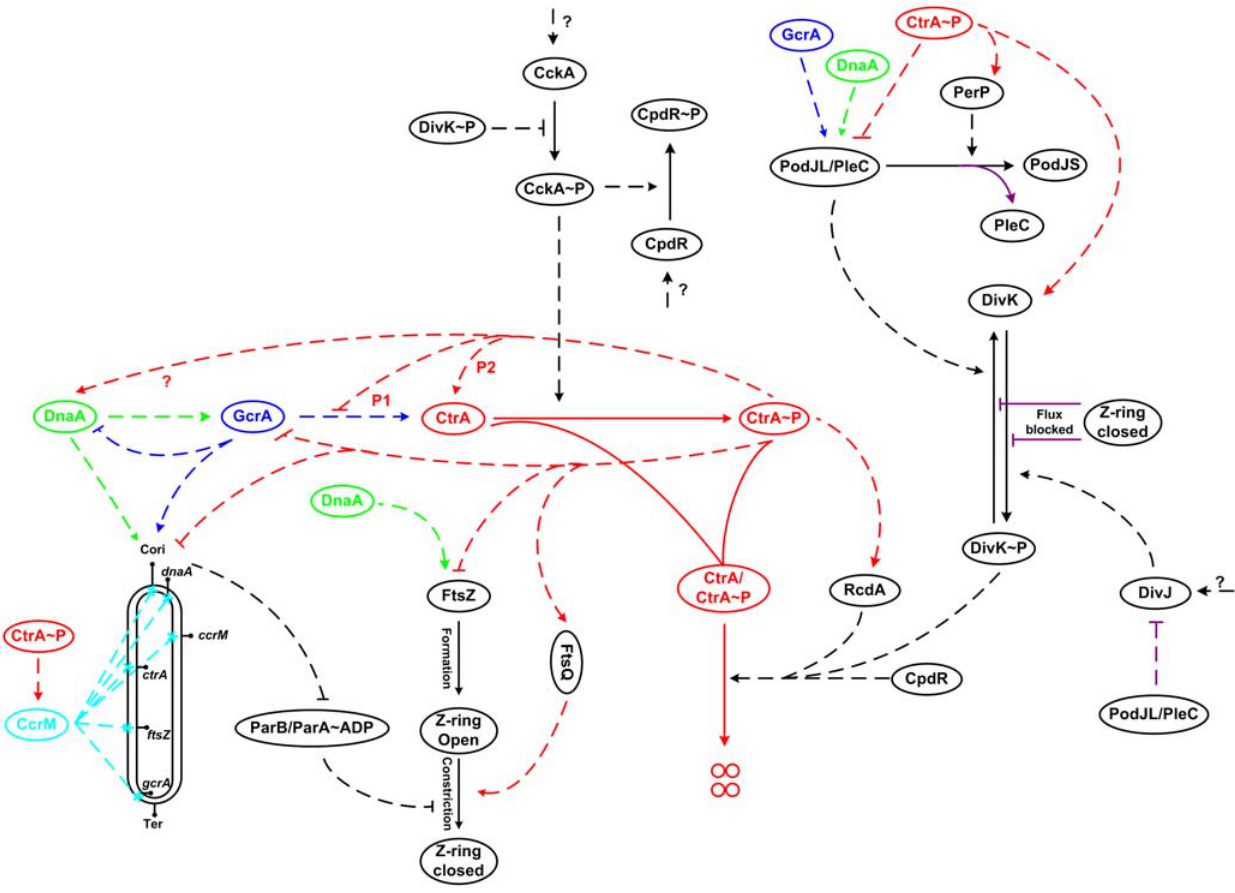
Figure 2. Wiring diagram of the model. All proteins (ovals) are assumed to be produced and degraded at specific rates. Only degradation of CtrA and CtrA , P is depicted explicitly (4 small circles indicate products of degradation), in order to show how these steps are regulated. Solid lines correspond to the mass flow while dashed lines denote regulatory effects. P1 and P2 denote the two promoters controlling CtrA production. Purple lines signify the role of localization/delocalization effects in corresponding regulations. The double-stranded closed curve at the bottom left represents DNA. C ori is the origin of DNA replication and Ter stands for the termination site. DNA methylation sites on genes are marked by cyan stars. Z-ring closure at the far right blocks the flux of DivK and DivK , P between swarmer and stalked cell compartments.